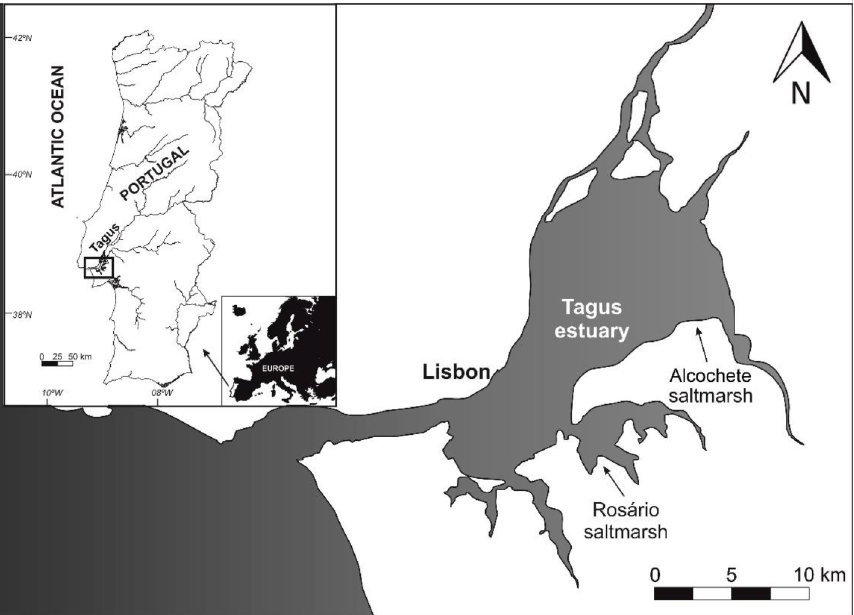
Figure 10. Tagus Estuary map with Alcochete (pristine) and Ros á rio (heavy metal contaminated) salt marshes sampling stations marked